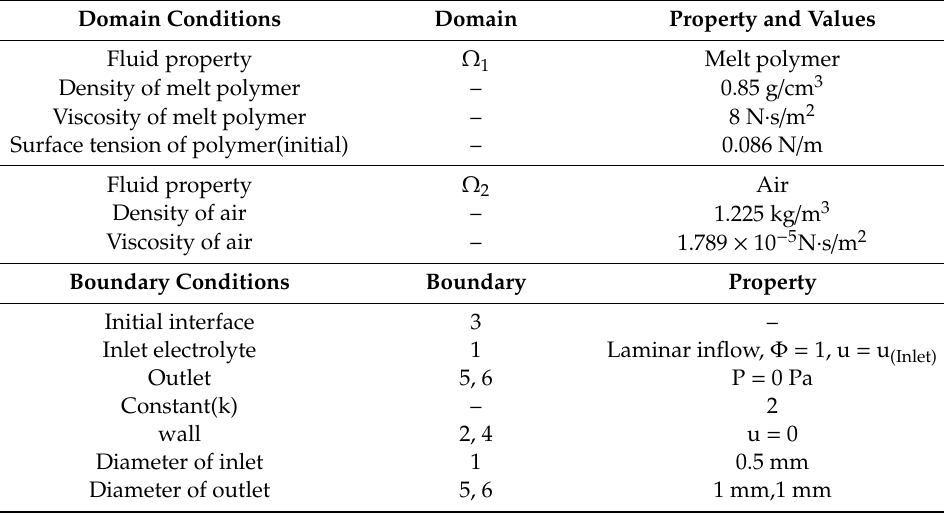
Table 1. Domain and boundary conditions for the simulations.